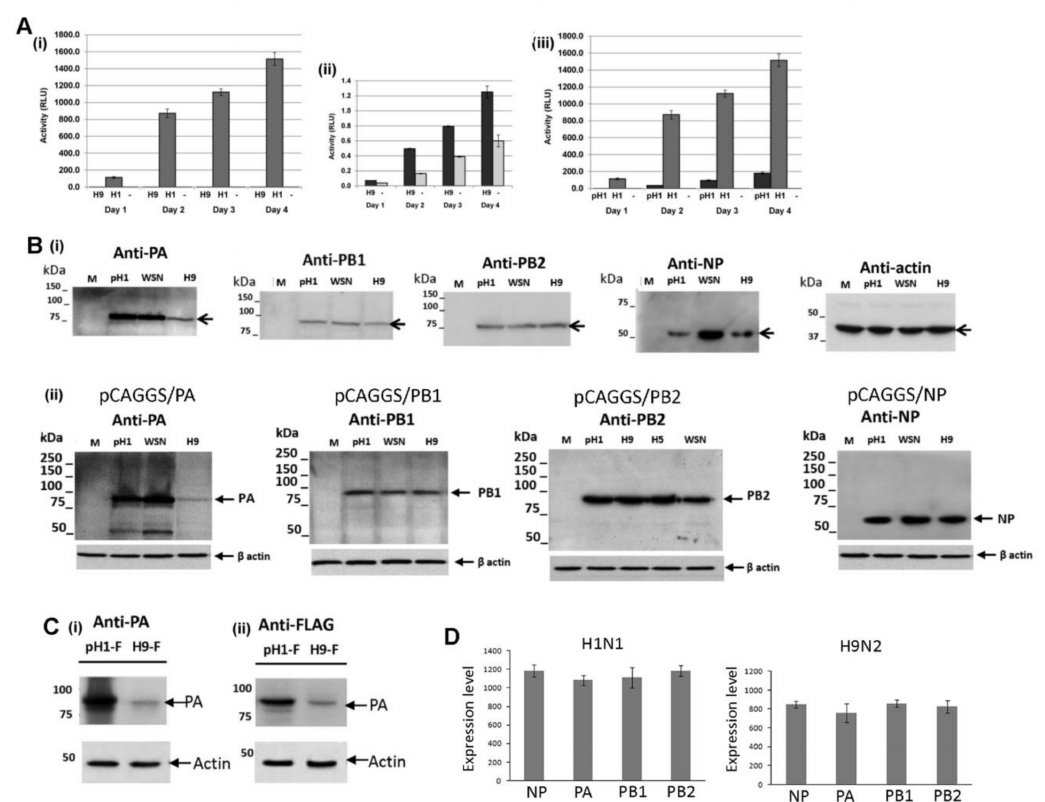
Figure 5. Expression of the recombinant H9N2 virus replication complex. ( A ) HEK293T cells were transfected with pCAGGS (M) and pPol1 / luc (-) or co-transfected with pPol1 / luc and pCAGGS / PA, pCAGGS / PB1, pCAGGS / PB2, pCAGGS / NP of the H1N1 / WSN(H1), pH1N1 / 471 (pH1) or H9N2(H9) viruses. The polymerase activity was assessed by measuring the luciferase activity (RLU) in the tissue culture supernatant over four days. The respective polymerase activities of ((i) and (ii)) the H1N1 / WSN(H1) and H9N2(H9) and (iii) the H1N1 / WSN(H1) and pH1N1 / 471 (pH1) are shown. In each case luciferase activity (RLU) in cells transfected with pCAGGS (M) and pPol1 / luc (-) is shown. ( B ) (i) After 24 hrs post-transfection (hptr) cells expressing the polymerase complex of each virus were examined by immunoblotting using anti-PA, anti-PB1, anti-PB2, and anti-NP. Protein bands correspondinginsizetotherespectivefull-lengthprotein(blackarrow)areindicated. Actinistheloading control and cells transfected with the parent vector pCAGGS is indicated (M). (ii) Cells were transfected with pCAGGS (M), pCAGGS / PA, pCAGGS / PB1, pCAGGS / PB2, pCAGGS / NP of the H1N1 / WSN(H1), pH1N1 / 2009 or H9N2(H9) viruses. At 24 hptr the cells were examined by immunoblotting using anti-PA, anti-PB1, anti-PB2 and anti-NP respectively. Protein bands corresponding in size to the full-length polymerase proteins are indicated (black arrow), and in each case actin is the loading control. Also shown is expression of the recombinant H5N2 PB2 protein (H5). ( C ) Cells were transfected with pCAGGS / PA-FLAG of the pH1N1 / 471 (pH1-F) or H9N2 (H9-F) viruses and after 20 hptr the cells were immunoblotted using either (i) anti-PA or (ii) anti-FLAG. The location of the PA-FLAG protein is indicated (PA) and actin is the loading control. ( D ) HEK 293T cells were transfected with either pCAGGS / PA, pCAGGS / PB1, pCAGGS / PB2 or pCAGGS / NP of the H1N1 / WSN (H1N1) and H9N2 virus and after 24 hptr the mRNA levels were quantified using PCR. Representative data from one experiment is